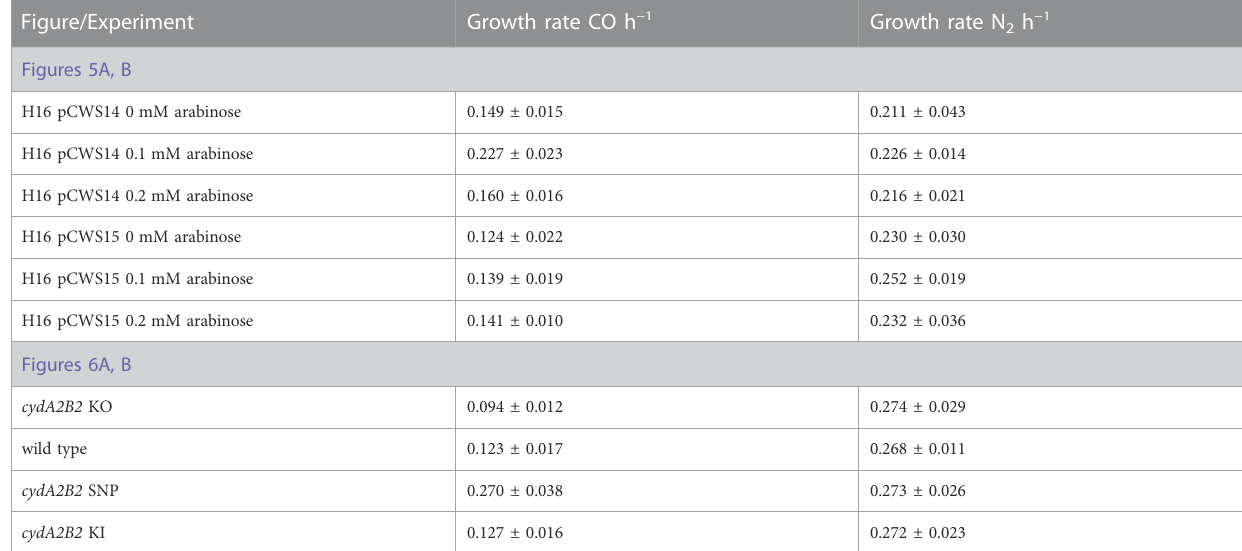
TABLE 5 Heterotrophic growth rates for wild type H16, H16 pCWS14, H16 pCWS15, cydA2B2 KO, cydA2B2 SNP and cydA2B2 KI. Figure/Experiment Growth rate CO h −